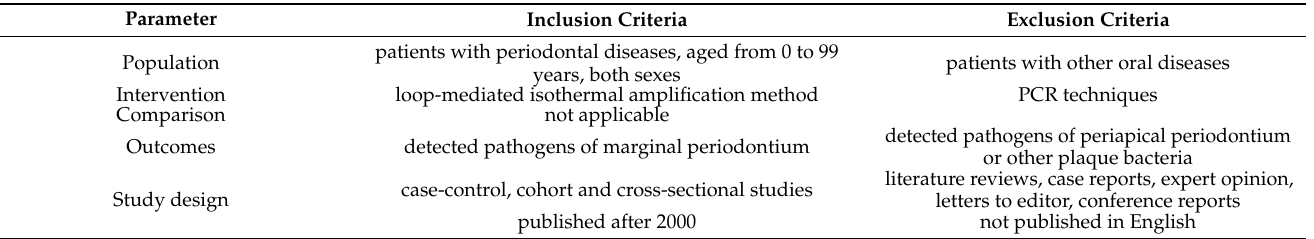
Table 3. Inclusion and exclusion criteria according to PICOS (“Population”, “Intervention”, “Comparison”, “Outcomes”, “Study